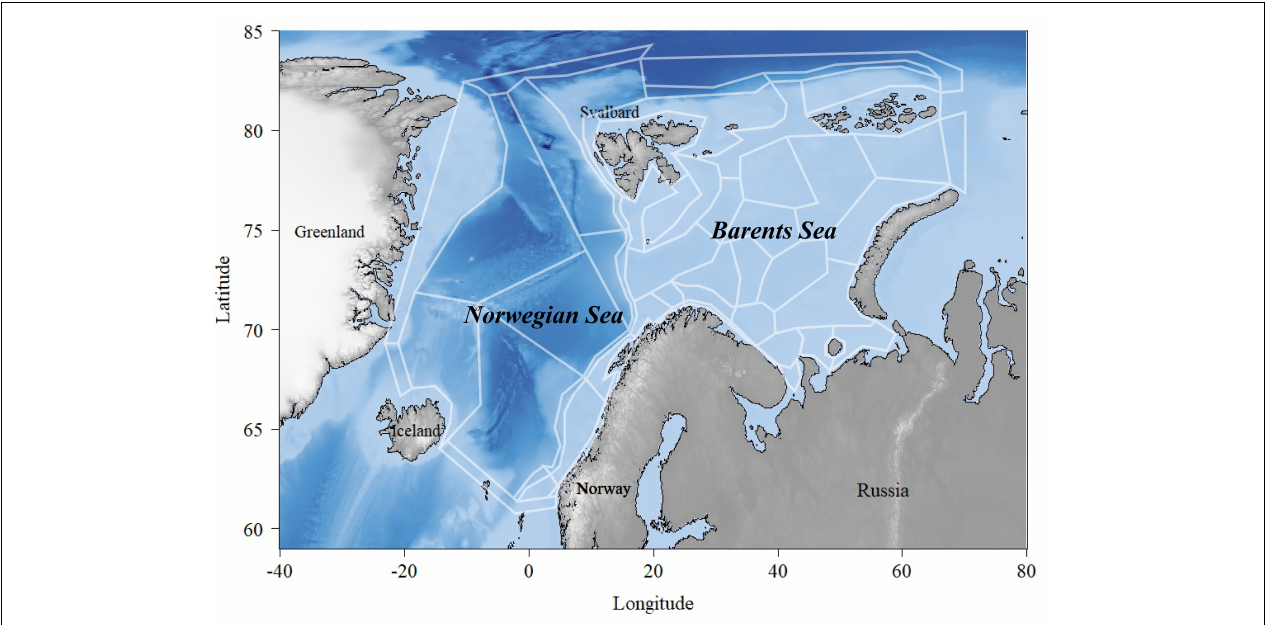
FIGURE 1 | Overview of the Norwegian and the Barents Seas covered by the polygons in the NoBa Atlantis